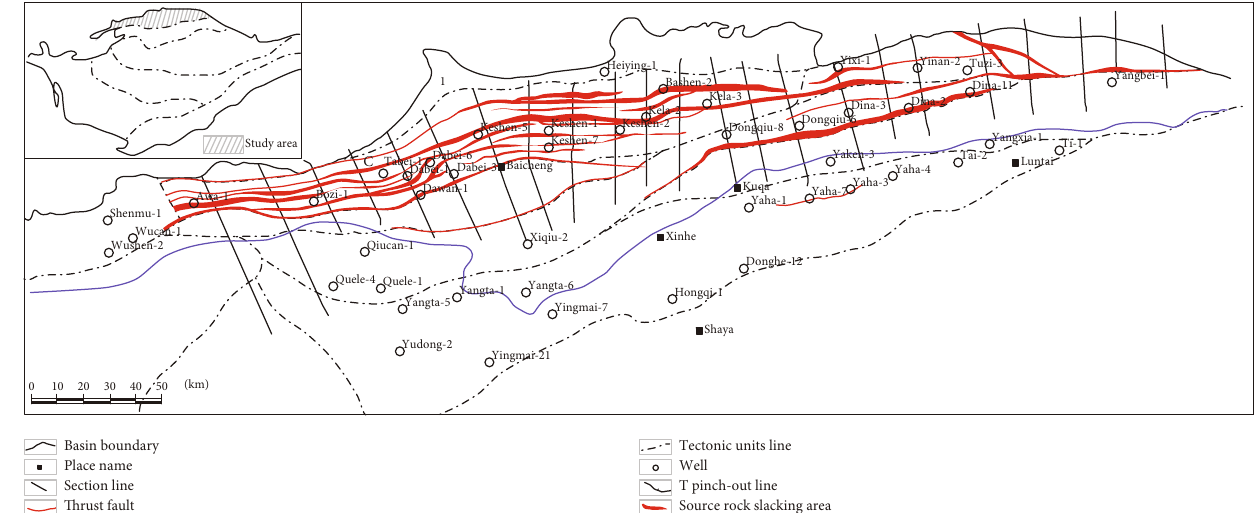
Figure 14: The source rock stacking areas related to the thrust faults in the Kuqa foreland